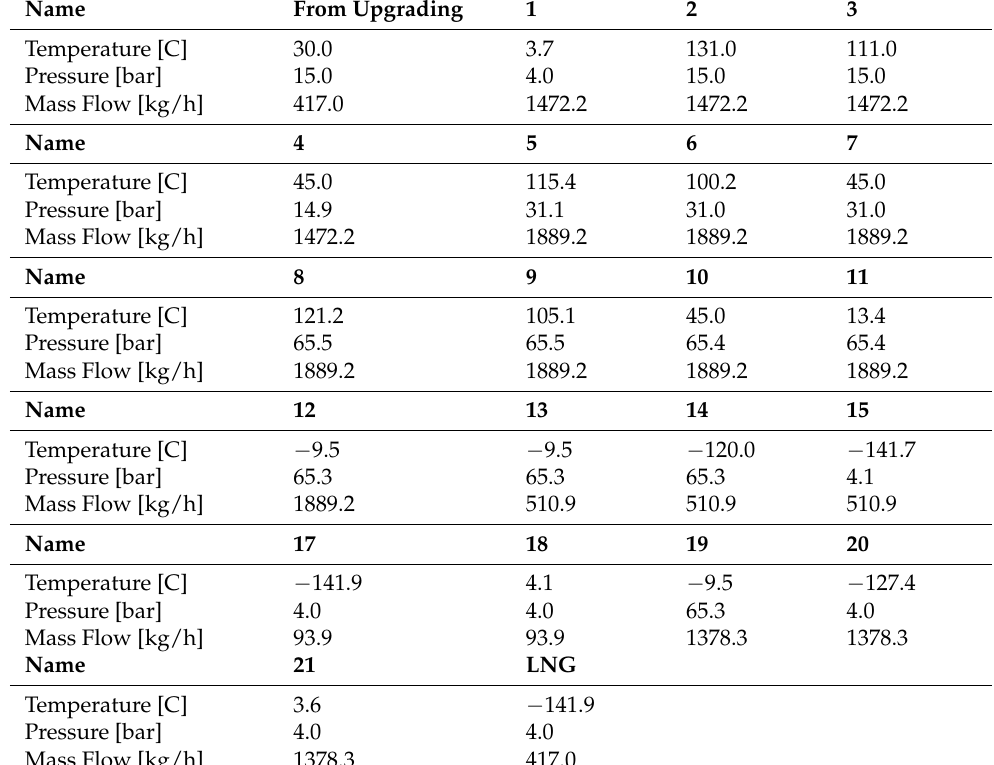
Table A7. States of the biomethane flows in AC-1.